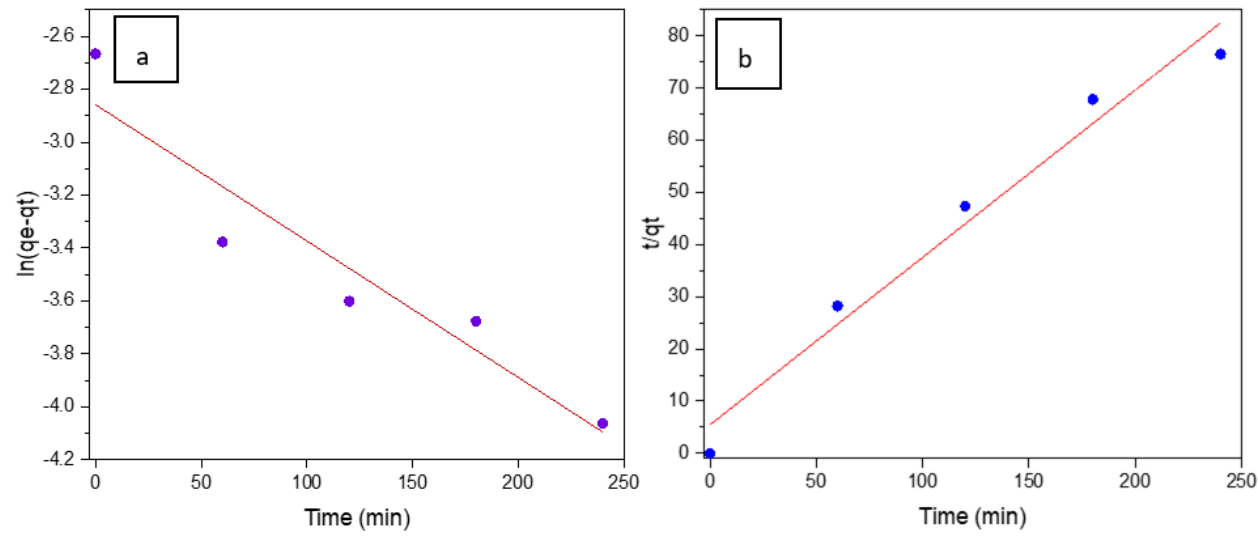
Figure 8. ( a ) PFO plot (Ln(qe-qt) vs. t, ( b ) PSO plot t/qt vs. t, for the SiC foam.